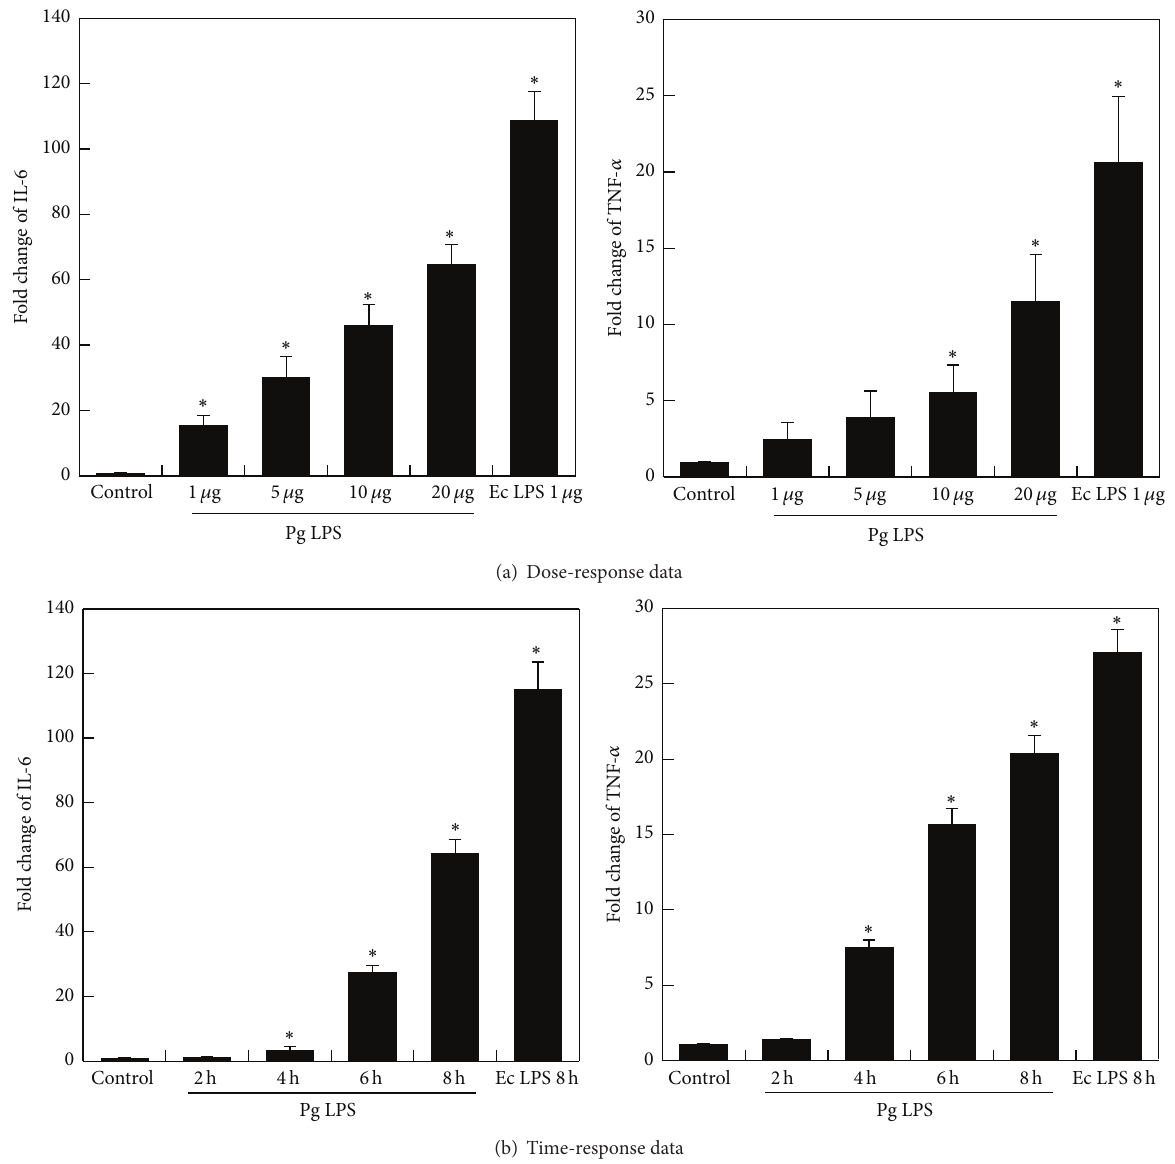
Figure 2: Effects of various doses of LPS and exposure times on the expression of TNF- 𝛼 and IL-6 in hDPCs. hDPCs were serum-starved for 24 h and treated with indicated concentrations of P. gingivalis LPS (1, 5, 10, and 20 𝜇 g mL −1 ) (a), for different times (2, 4, 6, and 8hrs) (b). The levels of TNF- 𝛼 and IL-6 mRNAs were determined by RT-PCR. Each value indicates the mean ± SEM of three independent experiments. ∗ indicates a significant difference ( 𝑃 < 0.05 ) relative to nontreated cells as control. E. coli LPS as positive control was treated 1 𝜇 gmL −1